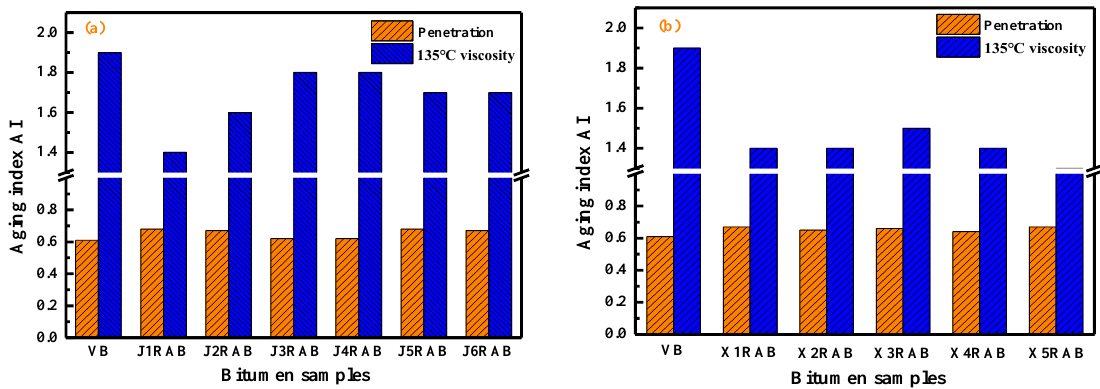
Figure 10. The aging index AI of virgin and rejuvenated binders after short-term aging.